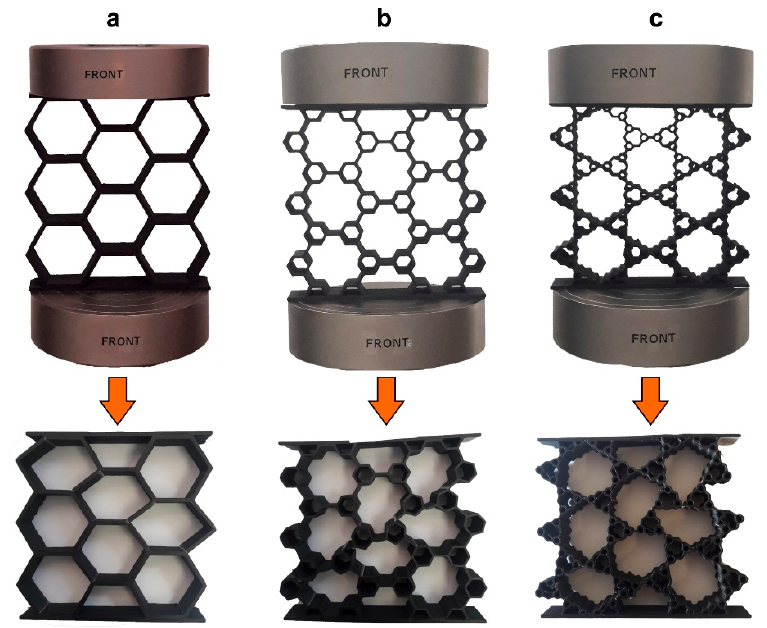
Figure 10. Comparison of the deformation behavior prior to and after compression testing for ( a ) regular honeycomb, ( b ) 1st level of hierarchy and ( c ) 2nd level of hierarchy.